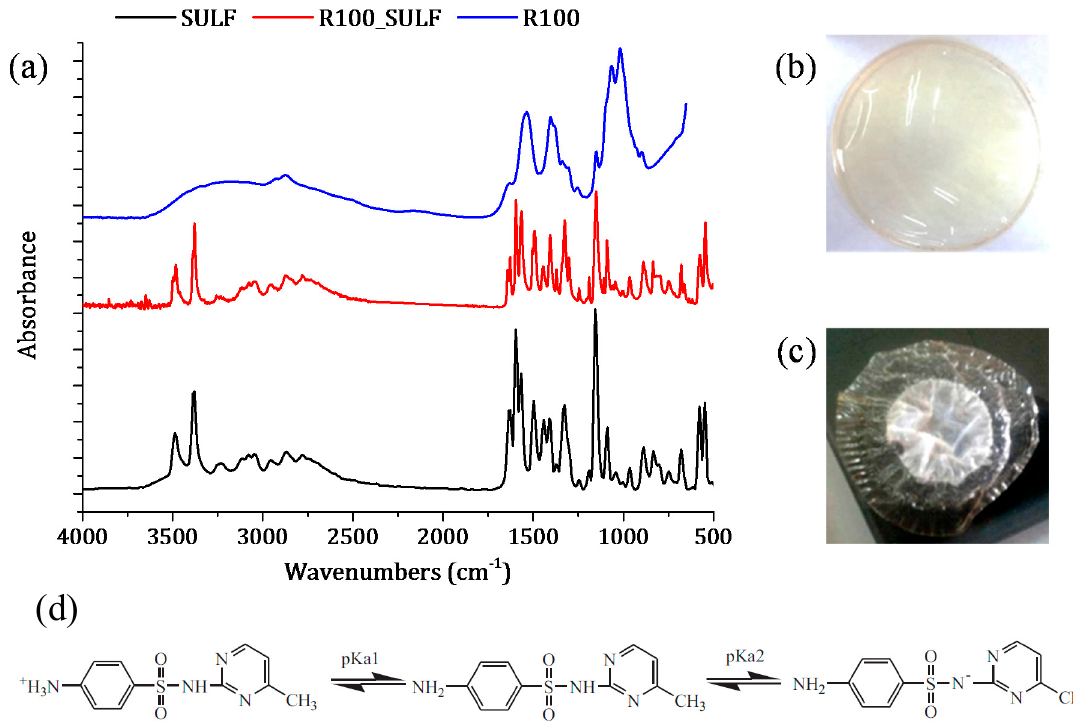
Figure 11. SULF sorption phenomenon of the chitosan membrane R100: ( a ) FTIR spectra of SULF and the chitosan membrane irradiated at 100 kGy before (R100) and after transport experiment (R100_SULF); images of the R100 membrane ( b ) before and ( c ) after SULF transport experiment. ( d ) Scheme illustration of dissociation equilibrium of SULF [52].